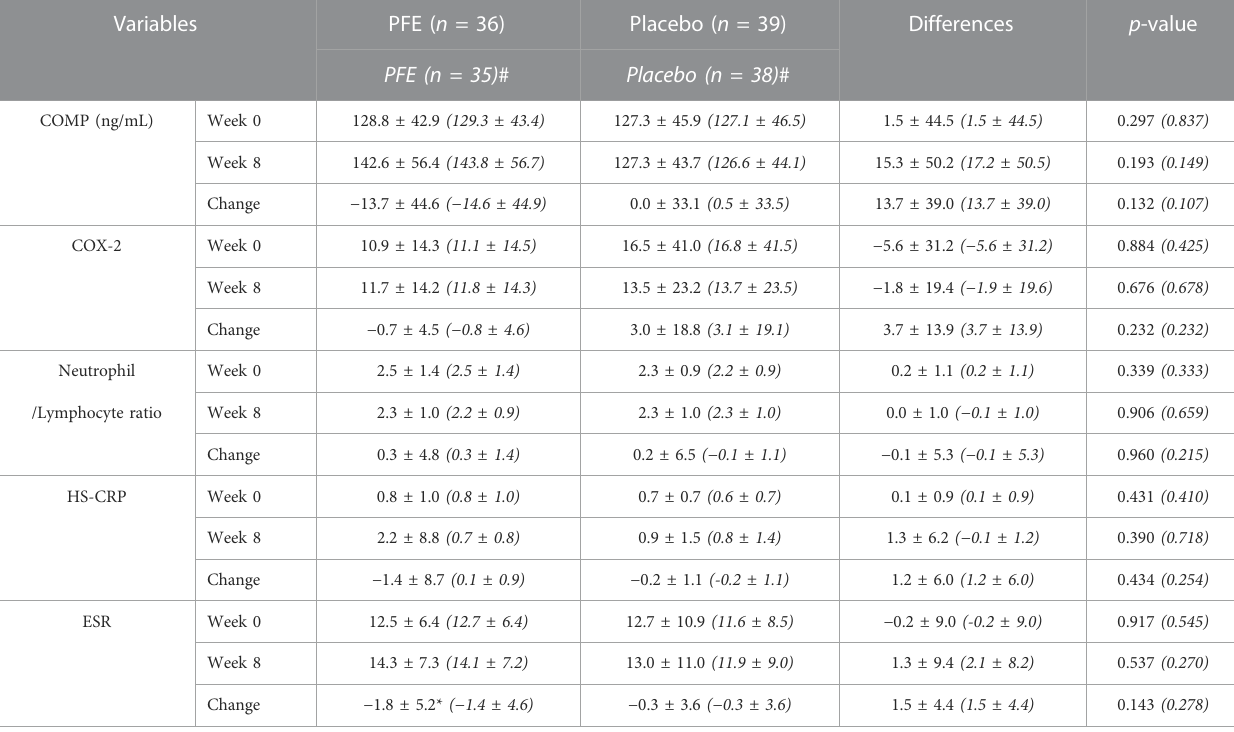
TABLE 3 Changes in secondary outcomes scores after 8-week